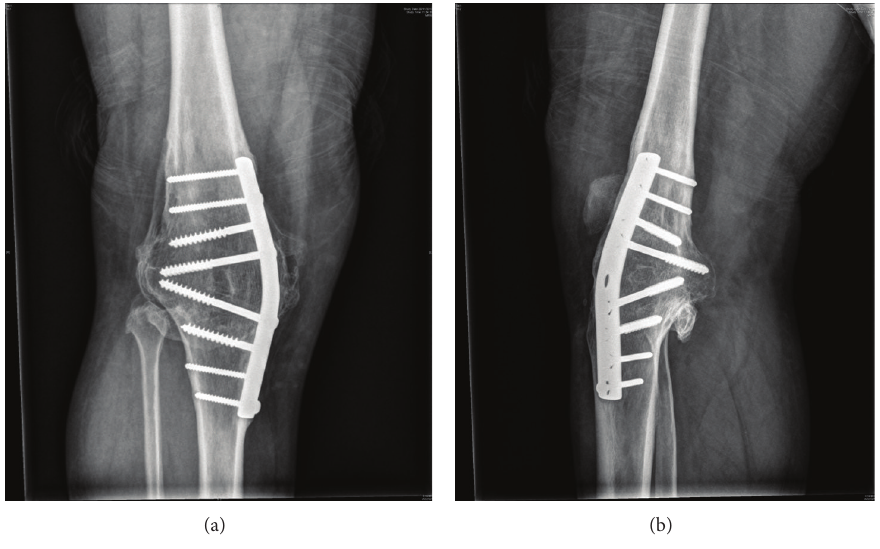
Figure 3: Arthrodesis with contoured